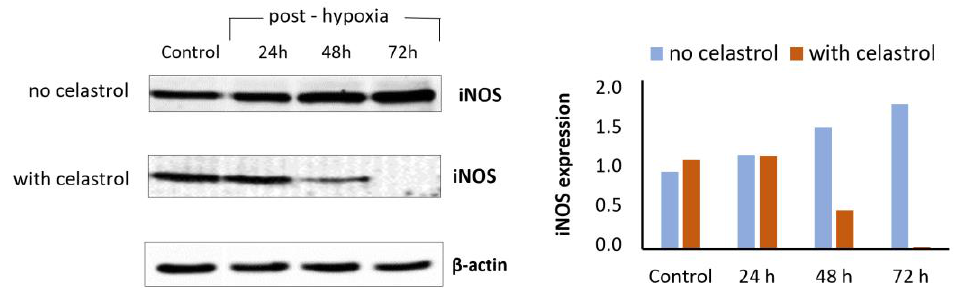
Figure 6. Expression of iNOS under hypoxic conditions and celastrol treatment. Western blot (immunoblot) assay with densitometric analysis revealed decrease in iNOS expression at 48 to 72 h post-hypoxia in BV-2 microglia cells that were pre-treated with 100nM celastrol following 6 h of hypoxia.